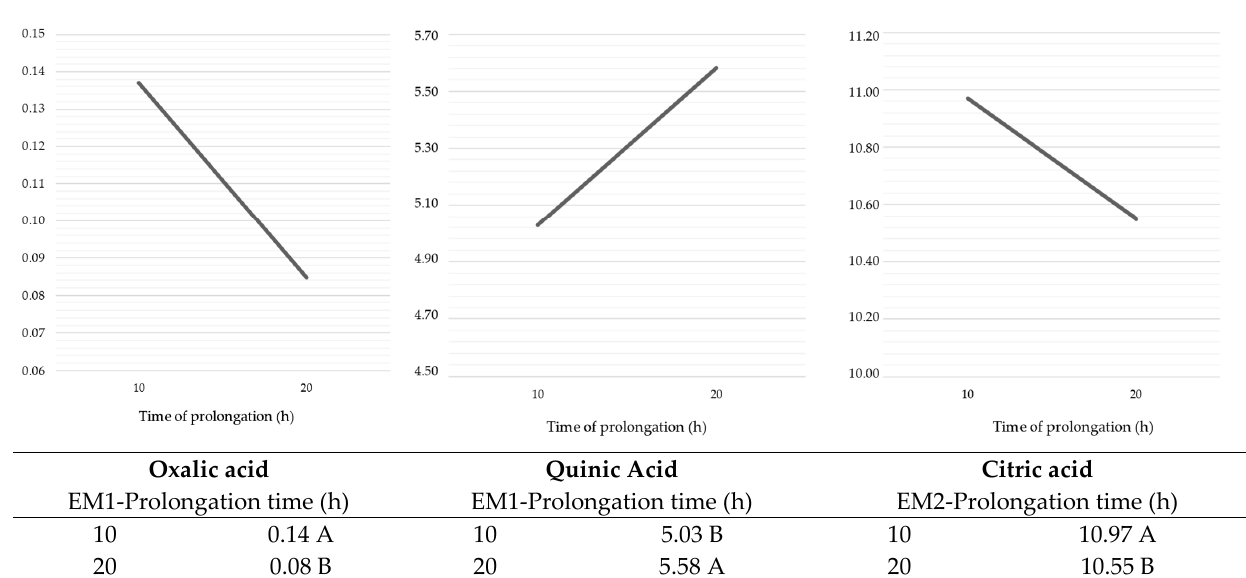
Figure 4. Effect of mucilage fermentation prolongation time on organic acids. Uncommon letters imply a difference in averages according to Duncan’s test (α = 0.05). Table 1. Average content of lipids, free fatty acids, protein, alkaloids, and total chlorogenic acids for coffee with different stages of maturity and prolonged fermentation of the